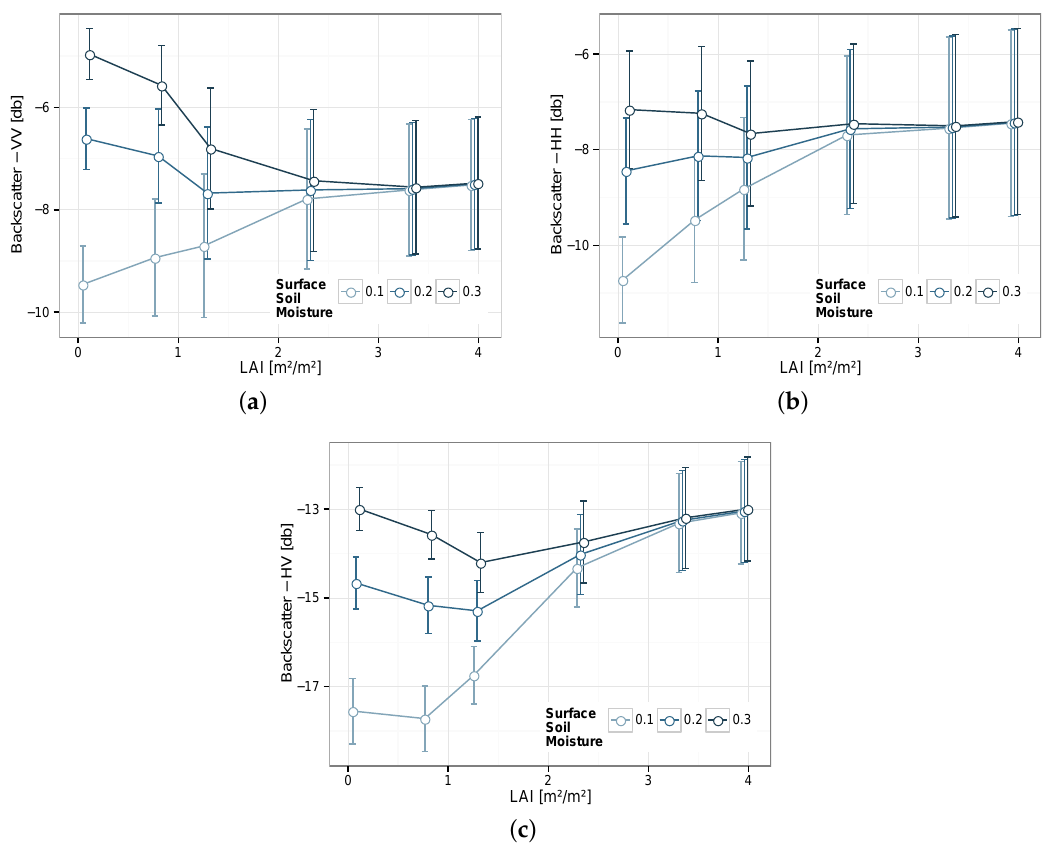
Figure 1. Average SAR backscatter profiles from the University of Tor Vergata (UTOV) dataset according to LAI for different soil moisture conditions in the ( a ) VV polarization, ( b ) HH polarization and ( c ) HV polarization. Confidence interval represent the standard deviation of the input data due to noise or variations in the acquisition angle. Soil moisture has a strong influence on the SAR backscatter when the crop cover is low (LAI < 3 m 2 /m 2